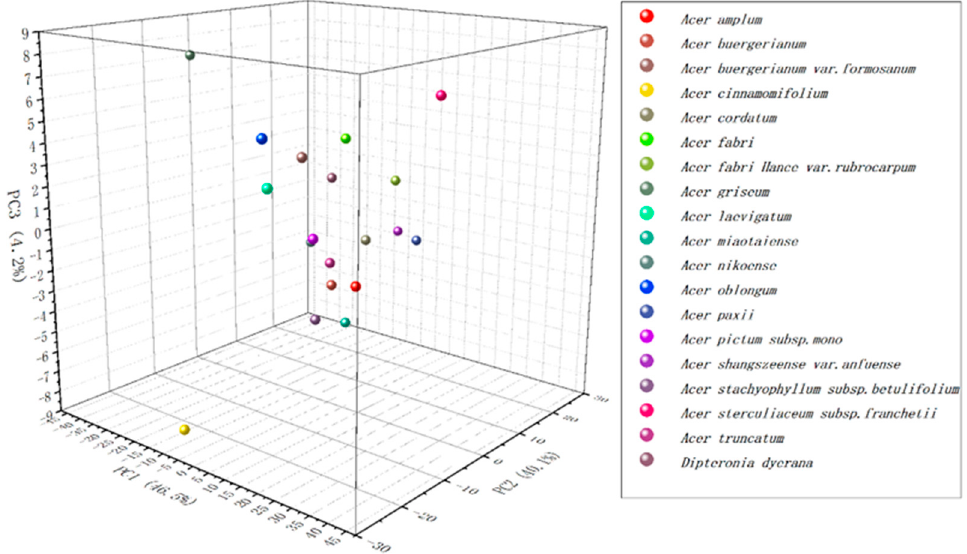
Figure 3. PCA analysis of A. shangszeense var. anfuense, A. pictum subsp. mono, A. amplum, A. truncatum, A. miaotaiense, A. nikoense, A. griseum, A. fabri Hance var. rubrocarpum, A. paxii, A. oblongum, A. laevigatum, A. buergerianum var. formosanum, A. cinnamomifolium, A. buer- gerianum, A. cordatum, A. fabri, A. sterculiaceum subsp. Franchetii, A. stachyophyllum subsp. bet- ulifolium, and Dipteronia dyerana based on electrochemical fingerprints.